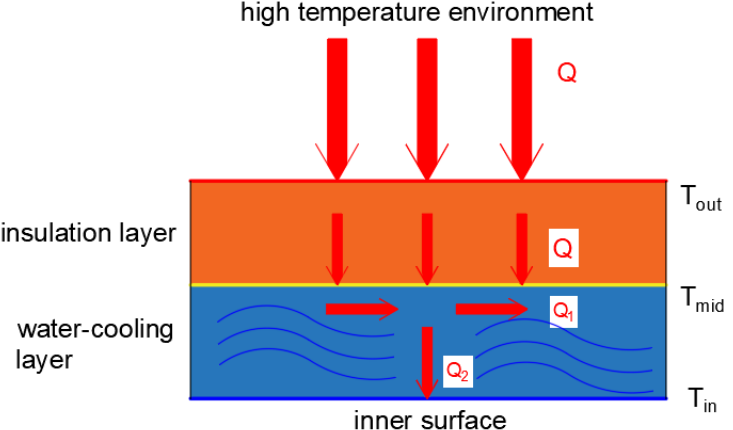
Figure 1. Insulation mechanism with hybrid technology, including passive and active